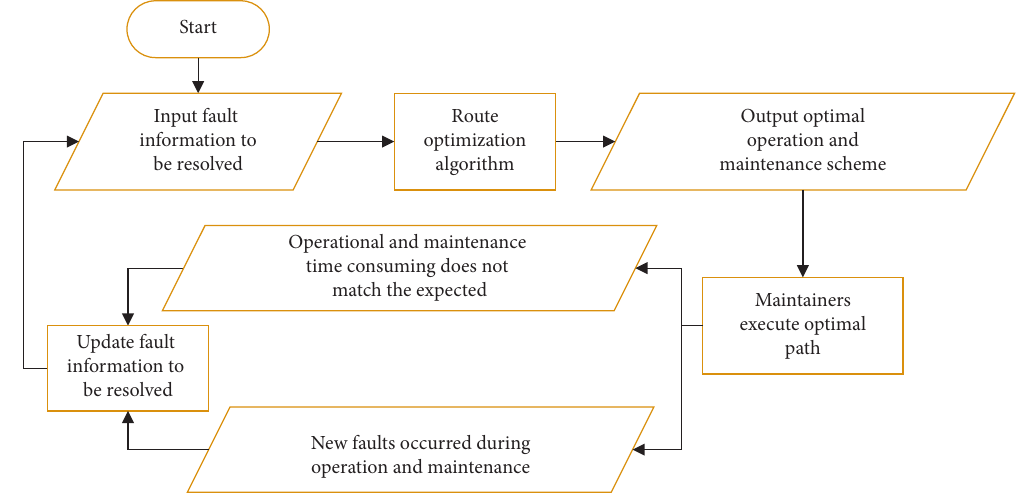
Figure 1: Operation process of fault diagnosis for PV